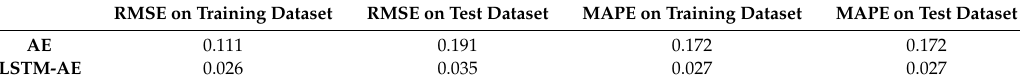
Figure 8. The performance of the LSTM-AE model on difference combination. Table 1. The comparison between the LSTM-AE and